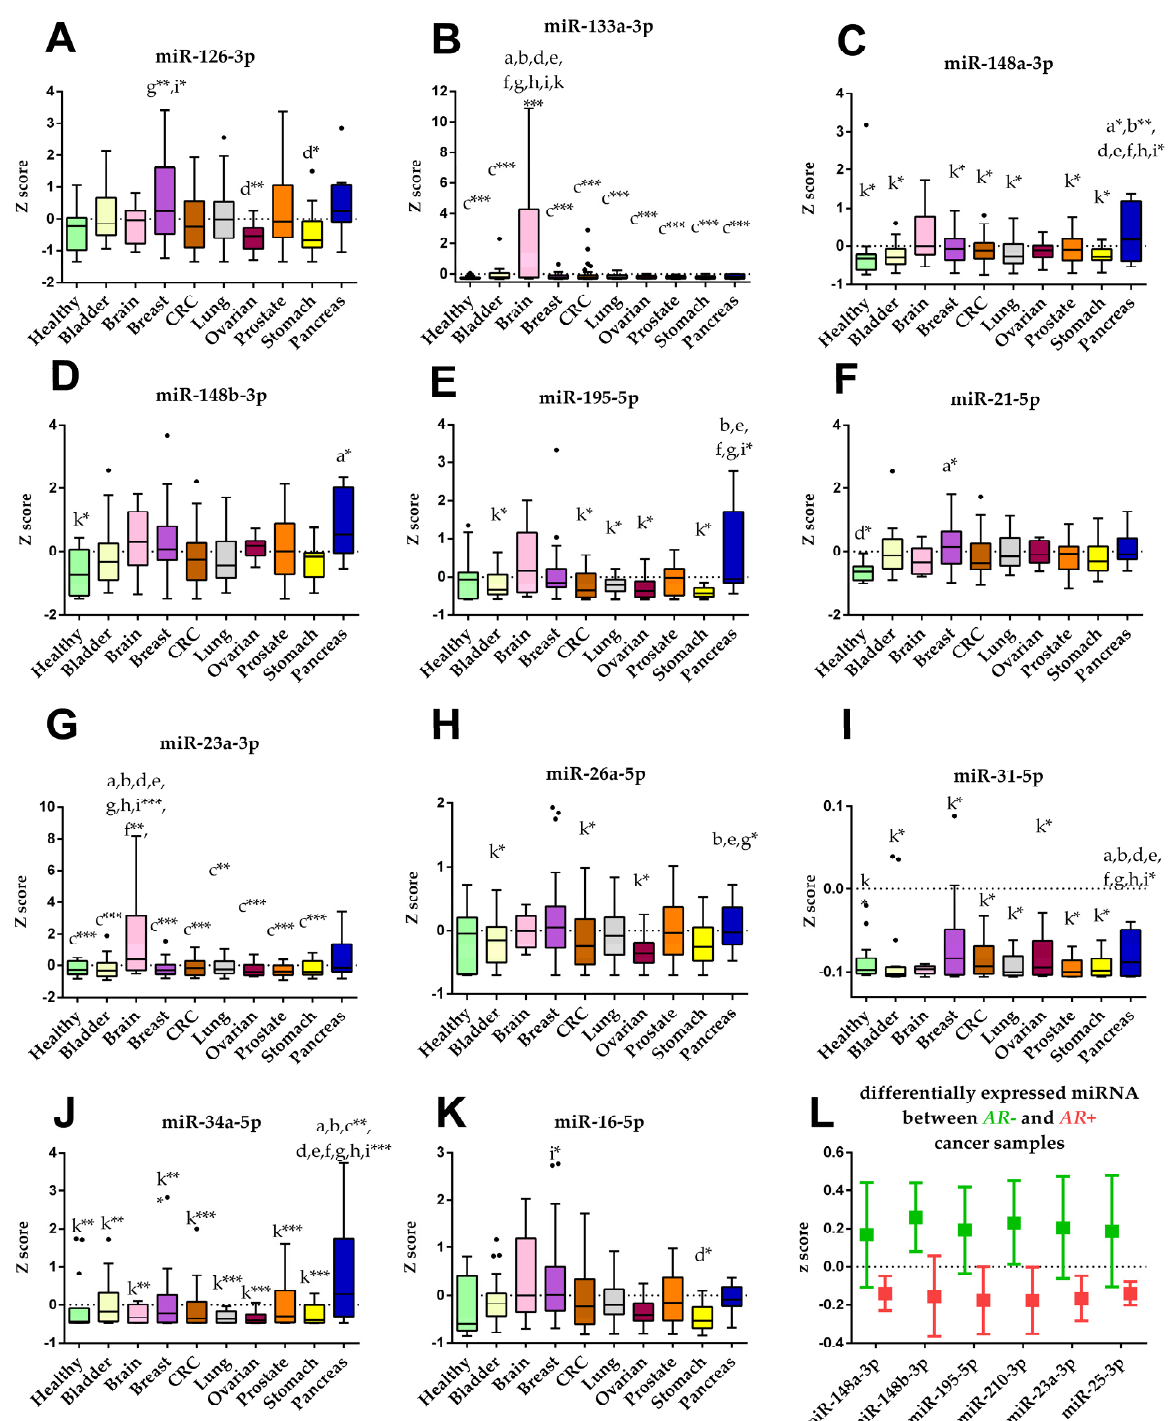
Figure 2. Cancer type specific miRNA expression levels. ( A – K ) Boxplots of the miRNAs deregulated between the different cancer types and control group (healthy). Boxes are the 25th to 75th percentile; the line is the median, and whiskers are 1.5 × IQR. Lower case letters indicate the group with significantly different miRNA levels: a healthy, b bladder, c brain, d breast, e CRC, f lung, g ovarian, h prostate, i stomach, k pancreas. ( L ) Grouped plot of the differentially expressed miRNAs between cancer samples with (AR+) and without (AR–) p.H875Y androgen receptor mutation. The line is the mean value, and whiskers are 95% CI. p -values are showed as * p < 0.05; ** p < 0.005; *** p < 0.001.